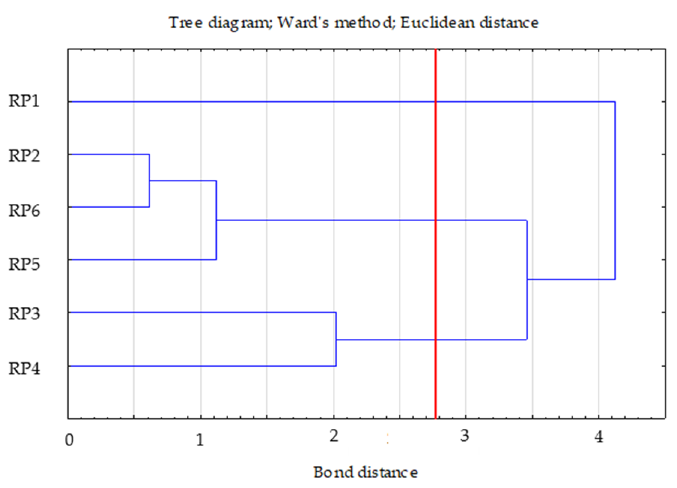
Figure 4. Tree diagram—Ward’s dendogram for dehydrogenases, phosphatase and urease. Two of the three variables significantly differentiate ( p < 0.05) the clusters obtained by the k-means method. These are dehydrogenase and urease activities (Table 8). Table 8. Analysis of variance (k-means method) for dehydrogenases, phosphatase and urease. Variable between SS df within SS df F Istotn. p dehydrogenases 4.68 urease